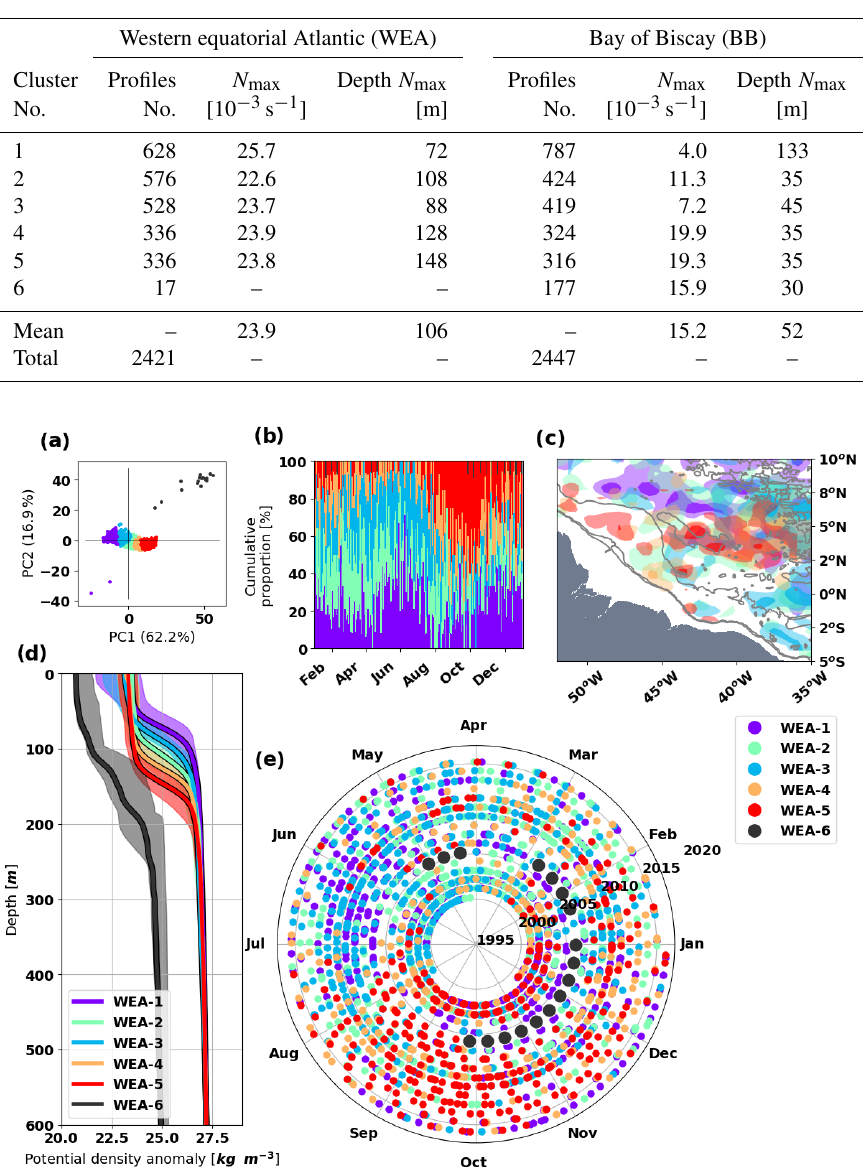
Table 1. Composition of the clusters and the characteristics of their stratification maximum for the western equatorial Atlantic and the Bay of Biscay. The depth of N max corresponds to the maximum of the buoyancy frequency.